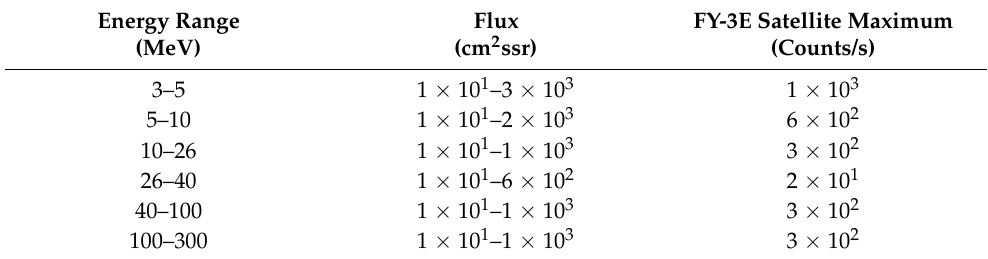
Table 4. Estimation of maximum count rate for high-energy proton probes.